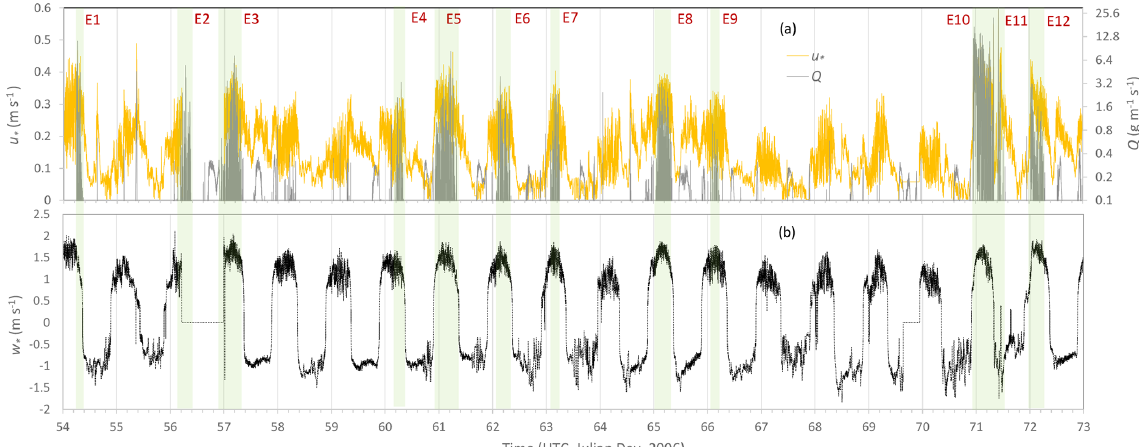
Figure 2. (a) One-minute averaged friction velocity, u ∗ , and streamwise saltation flux, Q , for the JADE observation time period; (b) 1min averaged convective scaling velocity, w ∗ . In addition to the 12 aeolian events marked, a number of weaker and intermittent aeolian events occurred.